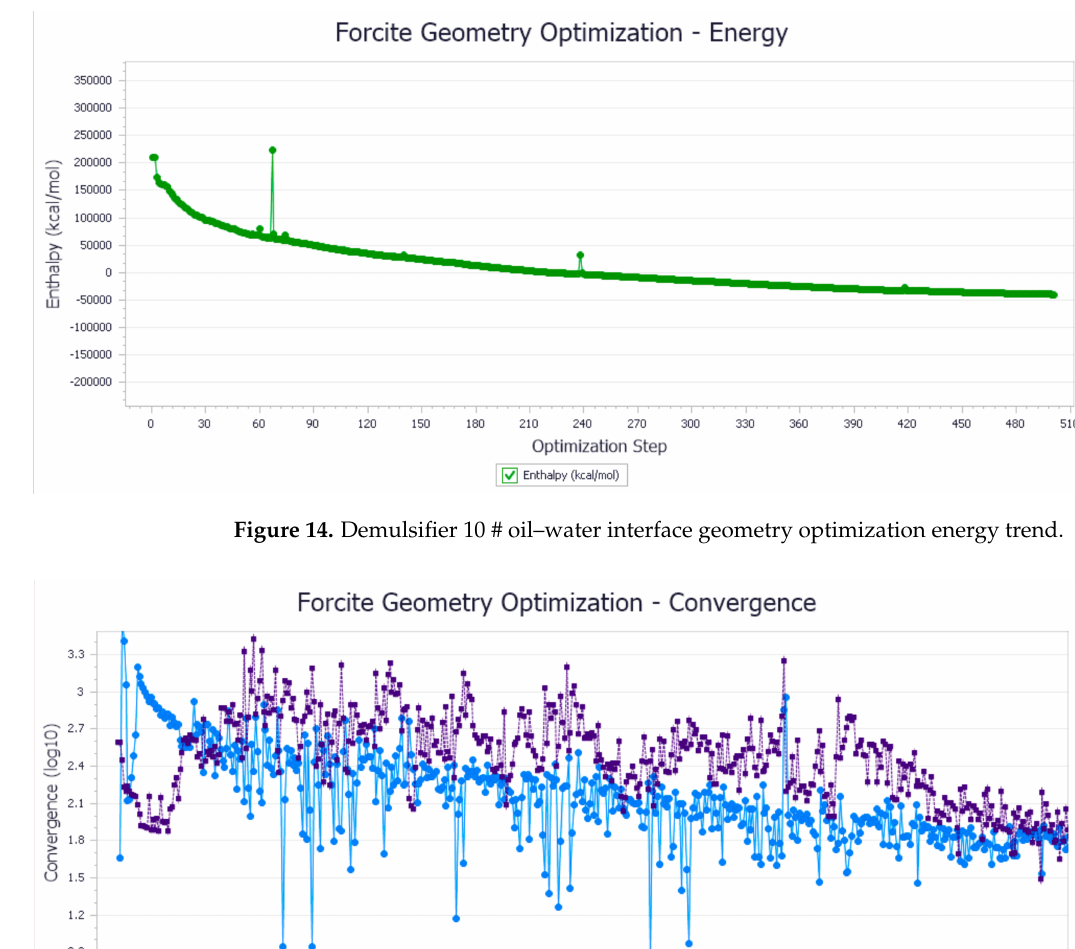
Figure 13. Demulsifier10# oil–water interface geometric optimization steps.